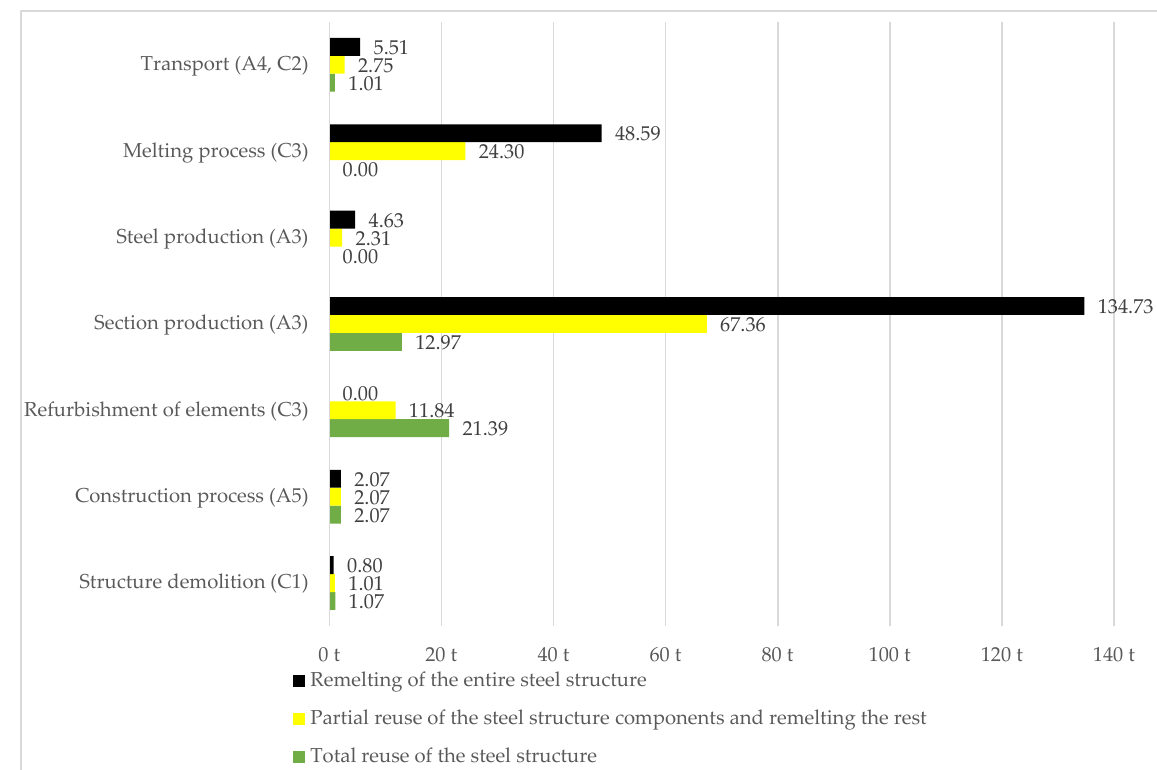
Figure 9. GWP 100 years values in three scenarios [t CO 2 eq.].